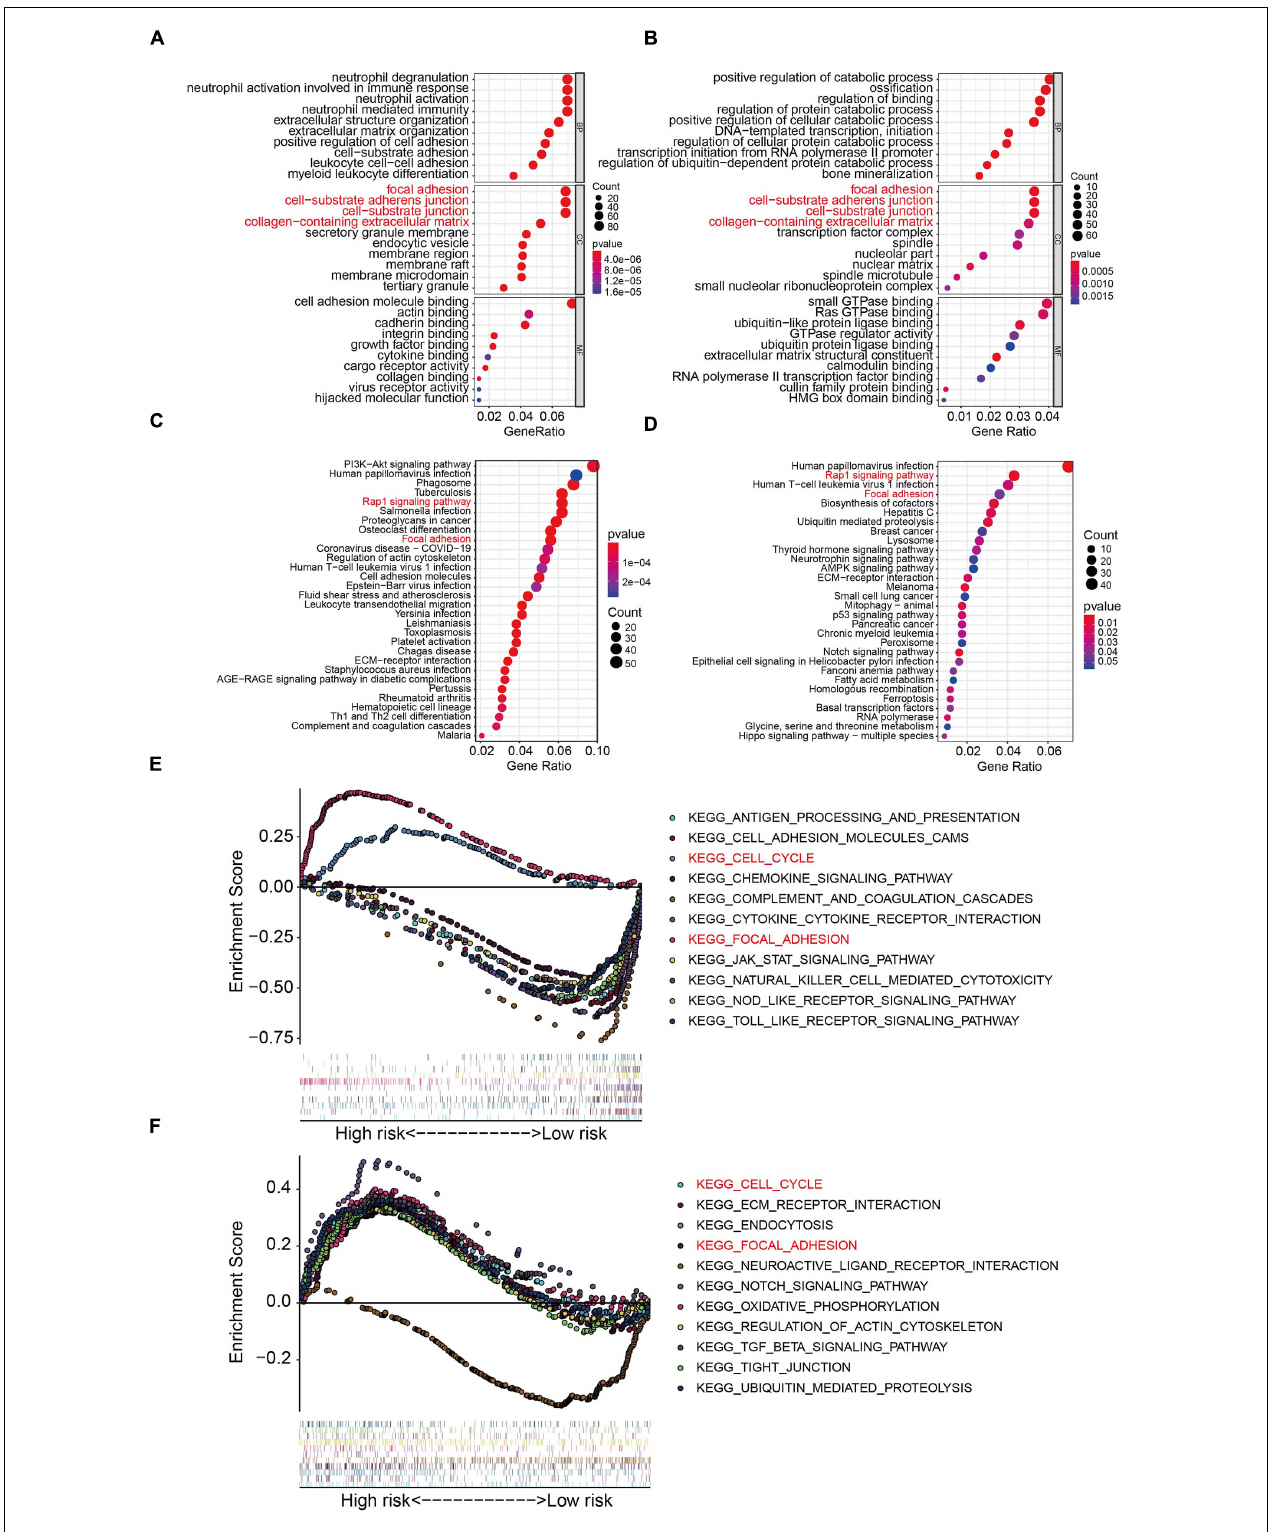
FIGURE 7 | Functional analyses in the TCGA osteosarcoma dataset and GSE39055 dataset. (A–B) GO analysis of differentially expressed genes between the high- and low-risk groups in the TCGA osteosarcoma and GSE39055 datasets. (C–D) KEGG enrichment analysis of the differentially expressed genes in the TCGA osteosarcoma and GSE39055 datasets. (E,F) Gene set enrichment analysis in the TCGA osteosarcoma and GSE39055 datasets.